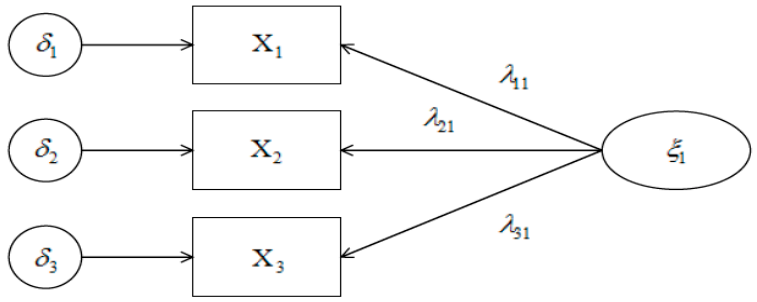
Figure 2. The measurement model in structure equation modelling.